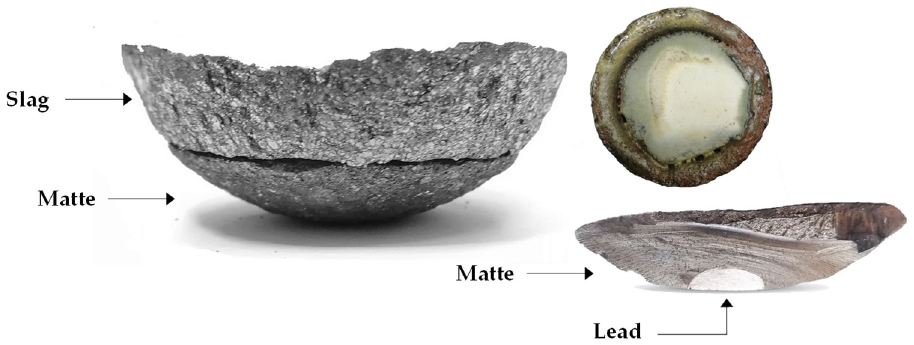
Figure 21. Final products of 83/13_S/4_C smelting.